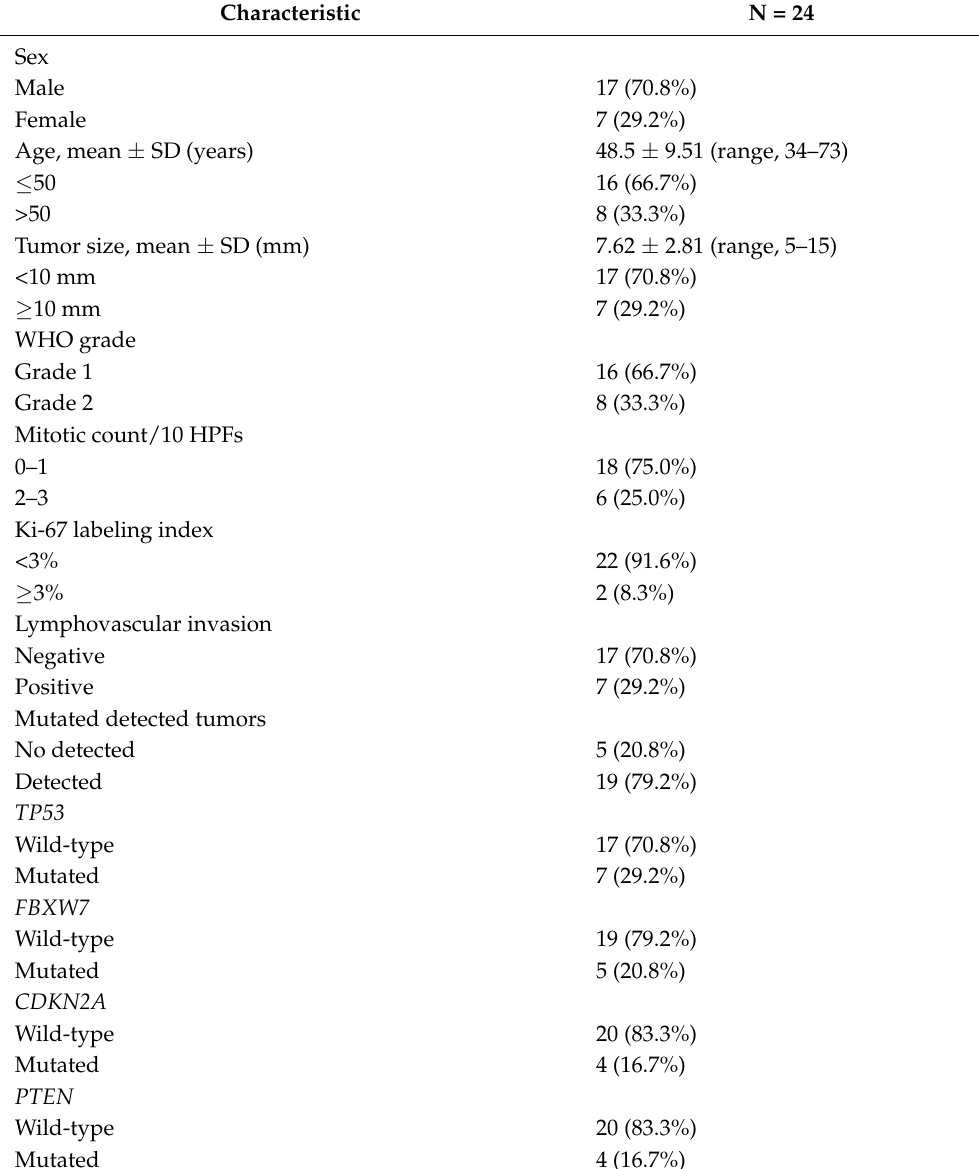
Table 1. Demographic and clinical features of patients with rectal neuroendocrine